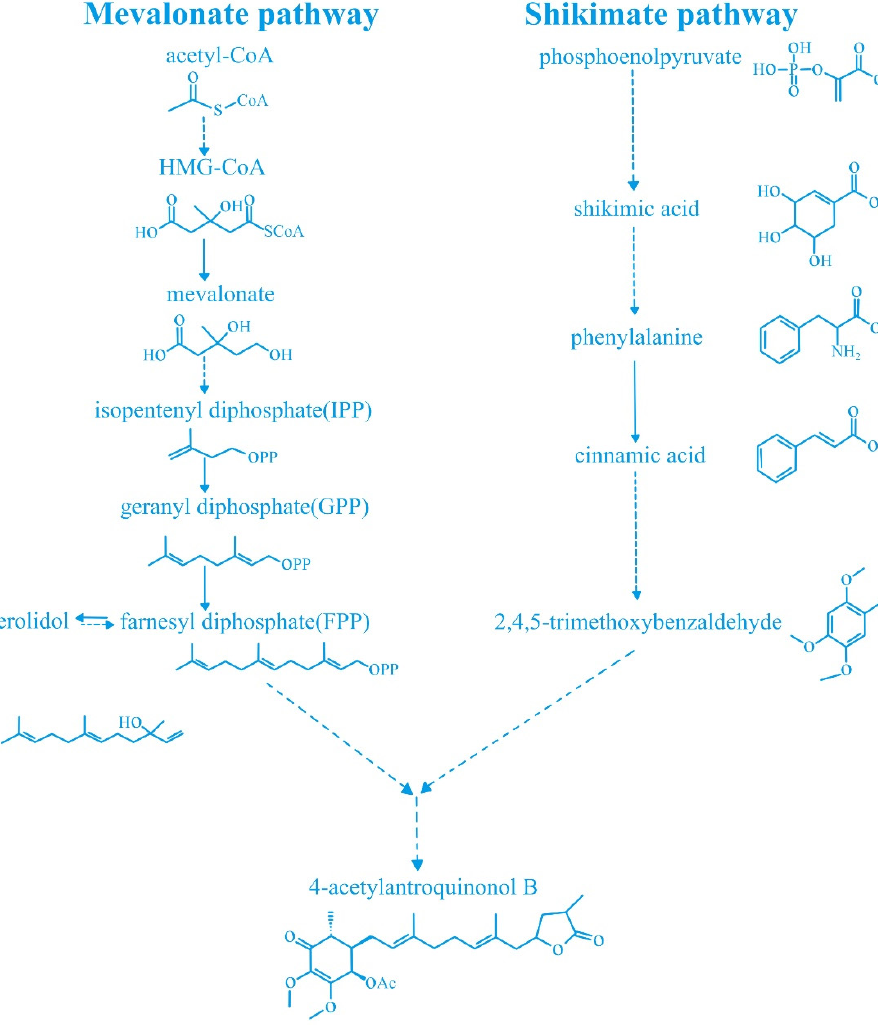
Figure 2. The proposed biosynthetic pathway of 4-acetylarylquinolinol B.